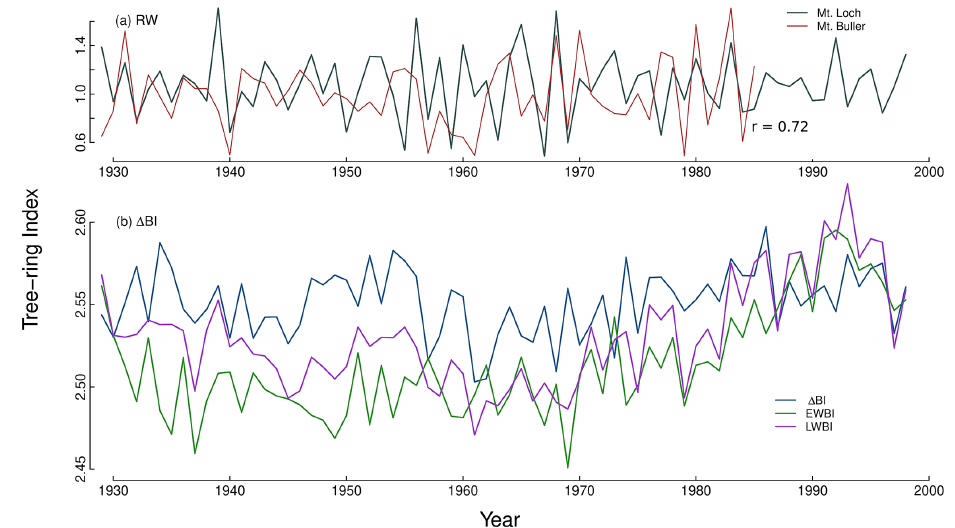
Figure 5. (a) Detrended P. lawrencei ring-width (RES) chronologies for Mt Loch (this study) and Mt Buller (Brookhouse and Graham, 2016) and (b) earlywood and latewood BI chronologies, with the derived (cid:49) BI parameter, for the 1929–1998